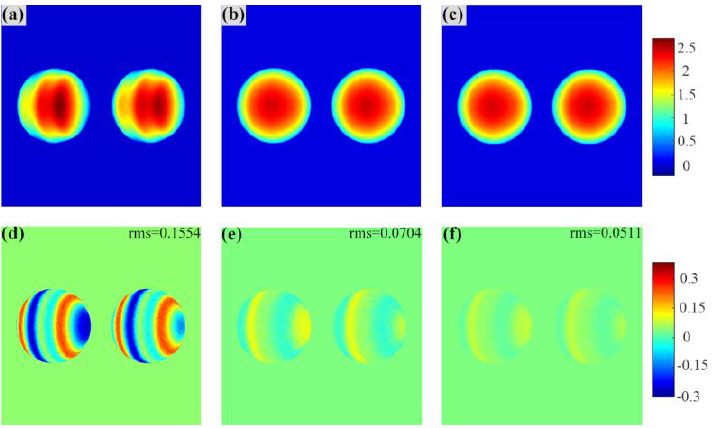
Figure 4. Results of the simulated spheres: ( a ) absolute phases recovered without corrections; ( b ) phase map obtained only with the histogram equalization; ( c ) phase map obtained with the whole proposed method; and ( d – f ) error maps corresponding to ( a – c ), respectively. Unit: rad.